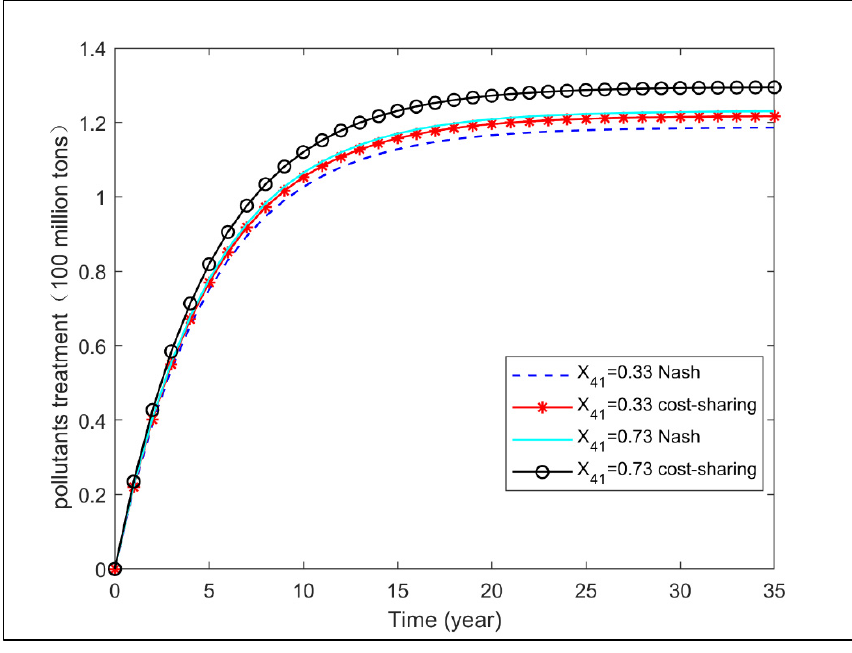
Figure 12. The Shanxi province effects on pollutants treated.